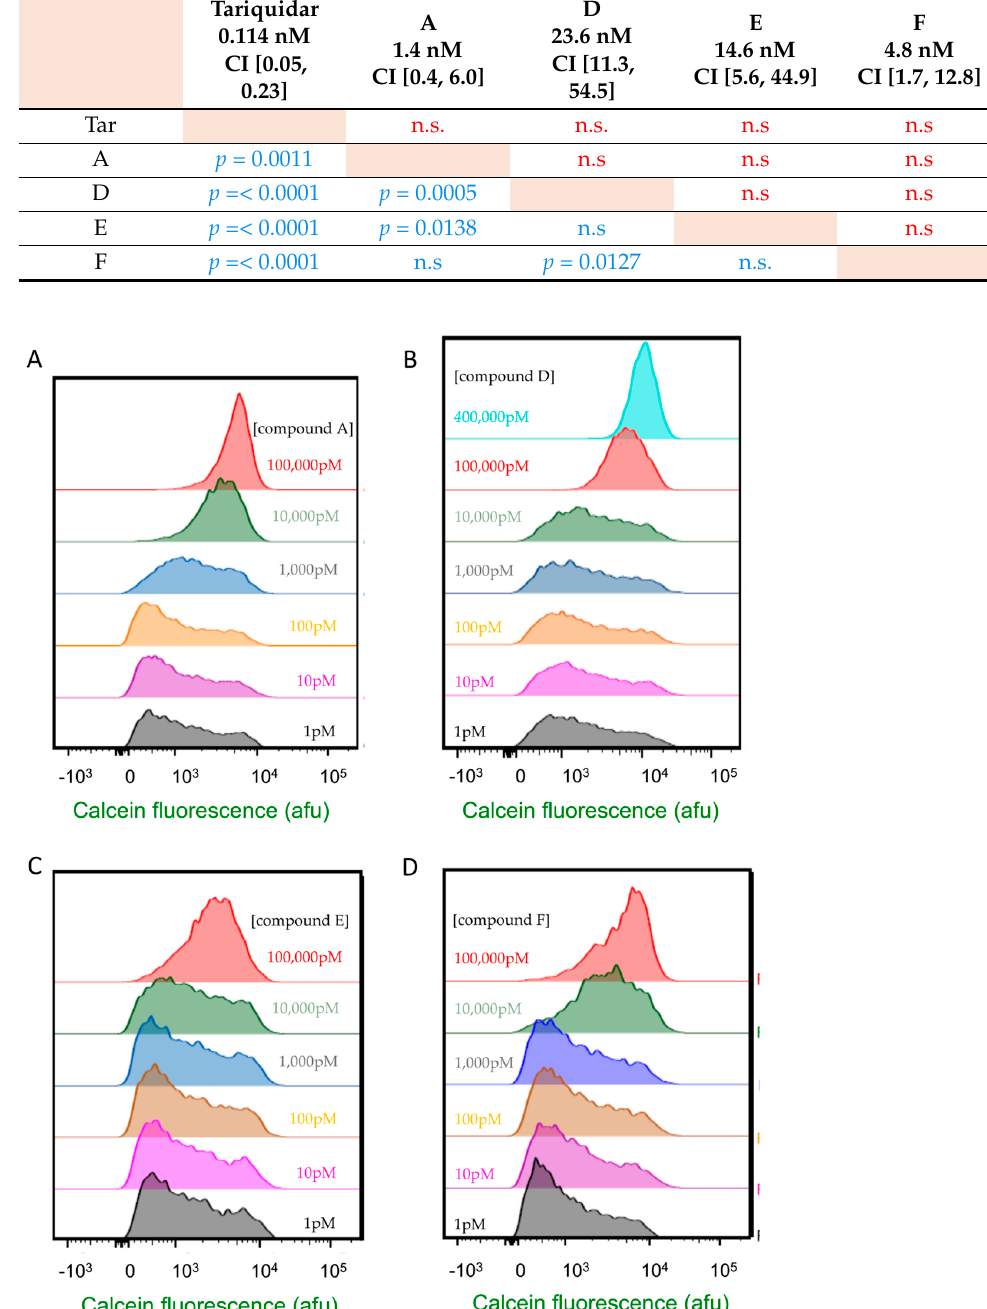
Figure 4. Potency of test compounds ‘A’, ‘D’, ‘E’, and ‘F’ for inhibition of ABCB1. ( A – D ) Histograms showing the increase in calcein accumulation in Flp-In-ABCB1 cells with increasing concentration of test compounds ‘A’, ‘D’, ‘E’, and ‘F’, respectively. ( E ) Non-linear regression analysis of ABCB1